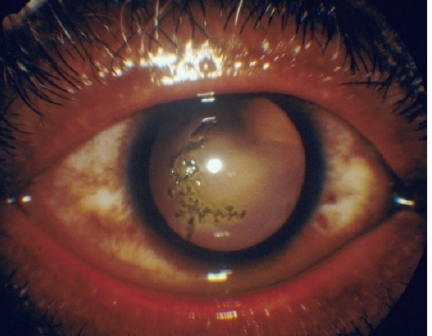
Figure 4. Herpes Simplex Dendritic ulcer (Photo Courtesy of Dr Linda